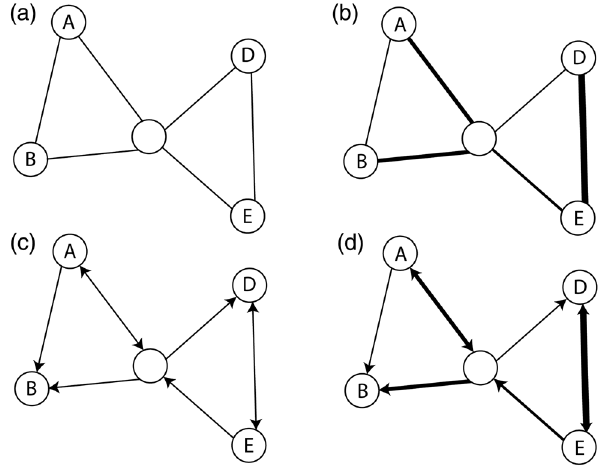
FIG. 1. Visualization of various types of networks. In undi- rected social networks, see (a) and (b), relationships or inter- actions are assumed to be reciprocal (e.g., if A is a classmate of B , B is naturally also a classmate of A ). In directed networks, see (c) and (d), the meaning of a relationship or an interaction is different from the initiator ’ s perspective (an arrow tail) than from its receiver ’ s (an arrowhead; e.g., A commented on B ’ s homework solution but B did not say anything about A ’ s work). In binary networks, see (a) and (c), only the presence of an interaction (pictured as an edge) matters, but not its frequency (illustrated by varying thicknesses of edges; e.g., A and B worked together on homework assignments while A and D did not). In weighted networks, see (b) and (d), more frequent interactions are assumed to be more meaningful (e.g., A and B worked together on homework assignments once while D and E worked together on homework assignments every